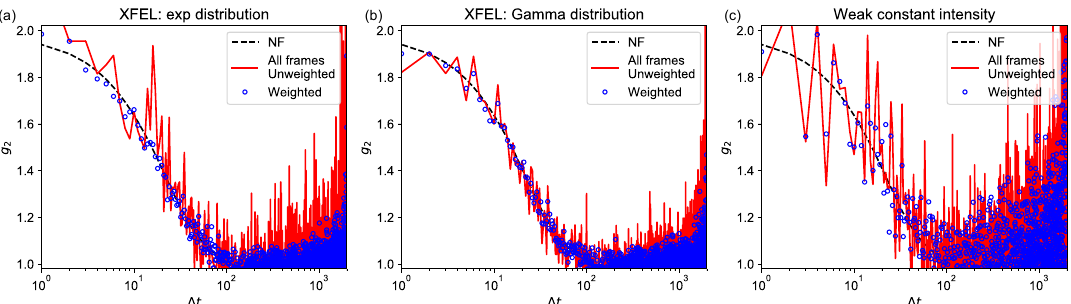
Figure 8. Reducing the noise and uncertainties in the determination of g 2 for the three simulated datasets in Figures 5–7 using a weighted g 2 function, Equation (10). ( a – c ) show the g 2 function calculated without (red curves) and with (blue symbols) the weighting factors, for the XFEL with exponential and Gamma-distributed intensities, and for the “all-weak” speckle